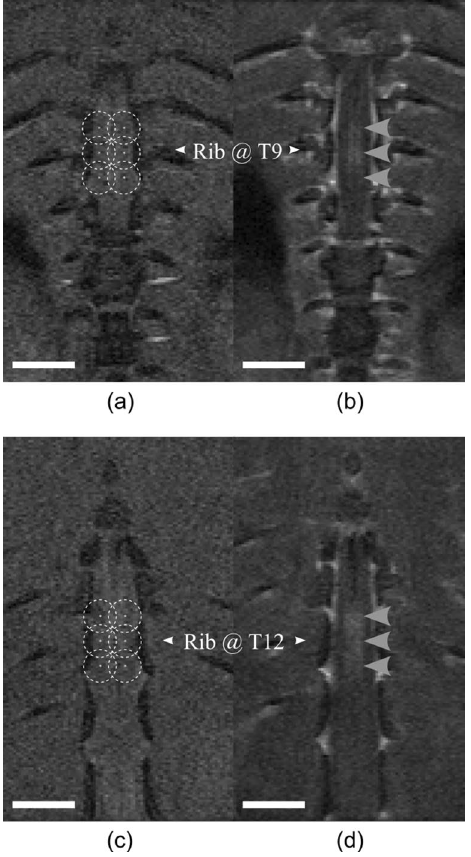
Figure 2. Example T1w coronal MR images pre- and post-FUS for drug delivery to the healthy spinal cord. ( a , c ) Pre-FUS treatment planning MR images. Points are spaced at a 2 mm pitch. Dashed circles represent the lateral beam width in water at the fundamental frequency (580 kHz). ( b , d ) Post-FUS gadolinium enhanced MR images showing enhancement within the spinal cord following BSCB opening (grey arrowheads). All scale bars = 5